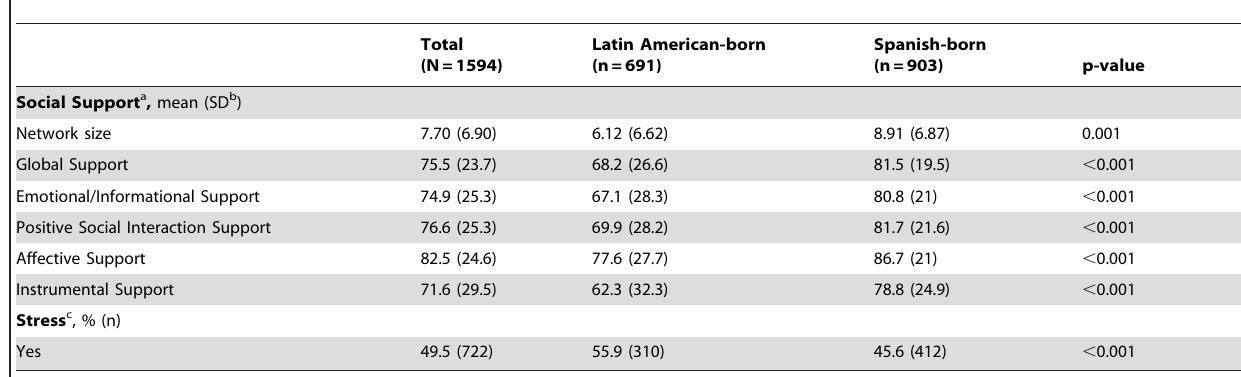
Table 2. Distribution of psychological variables of the study population, stratified by country of